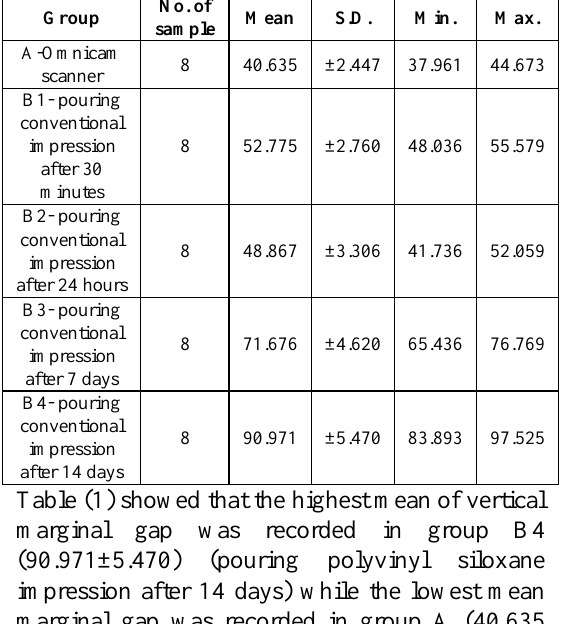
Table 1: Descriptive statistics of vertical marginal gap for the five groups in (μm)